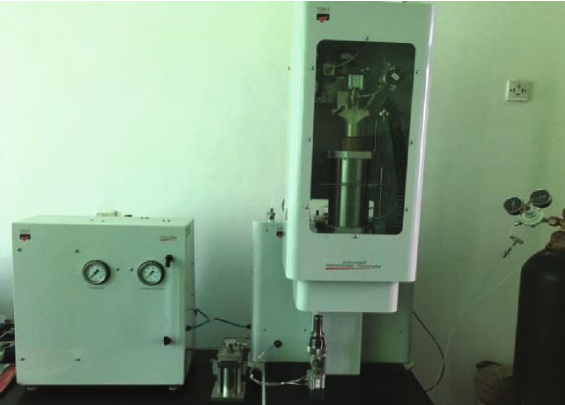
Figure 1: Schematic diagram of the experimental set-up.